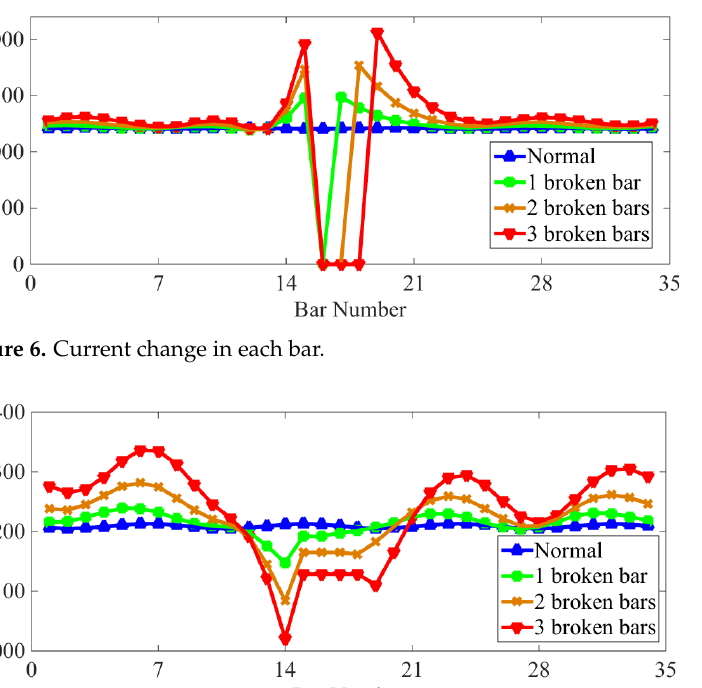
Figure 5. Stator phase A current: ( a ) normal; ( b ) one broken bar; ( c ) two broken bars; ( d ) three broken bars.